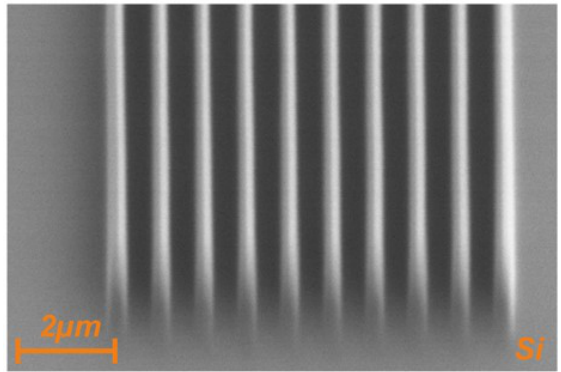
Figure 1. SEM image of subwavelength structures, the full grat- ing layout is shown in Figure 3. Image: Patrick